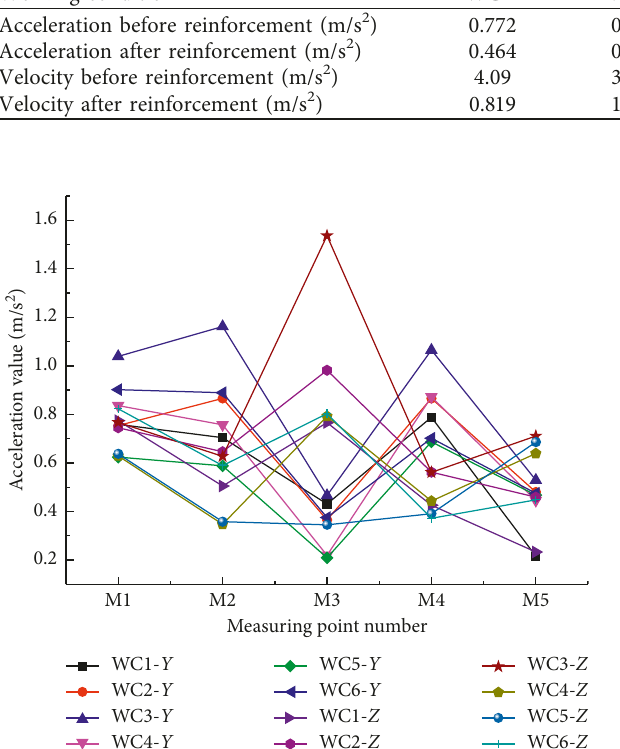
Figure 13: Peak accelerations.